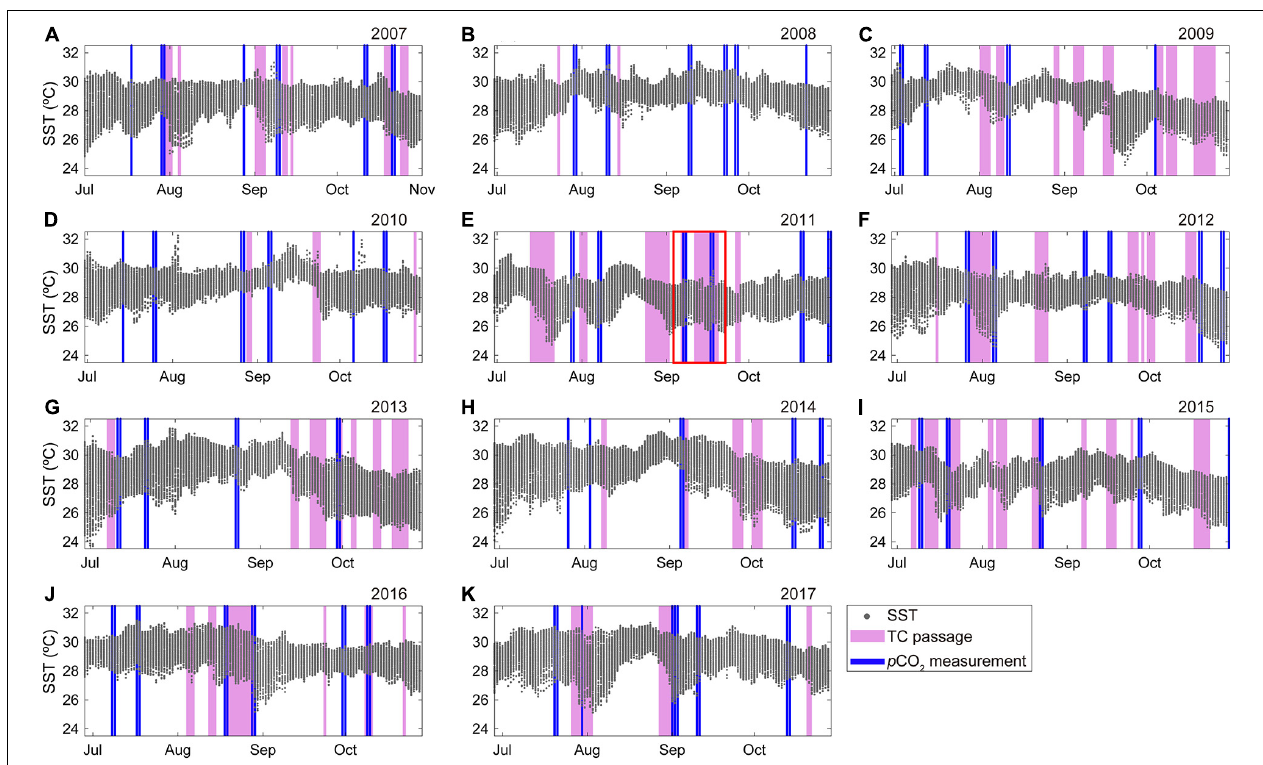
FIGURE 3 | (A–K) Distributions of gridded SST values (black dots) in the study region (22 ◦ N–28 ◦ N, 135 ◦ E–145 ◦ E) during TC season (July-October) of 2007-2017. Pink shading represents the period of TC passage and blue lines indicate the date of in situ p CO 2 measurements. SOCAT p CO 2 measurements in the red solid box in (E) were shown in Figure 2D .